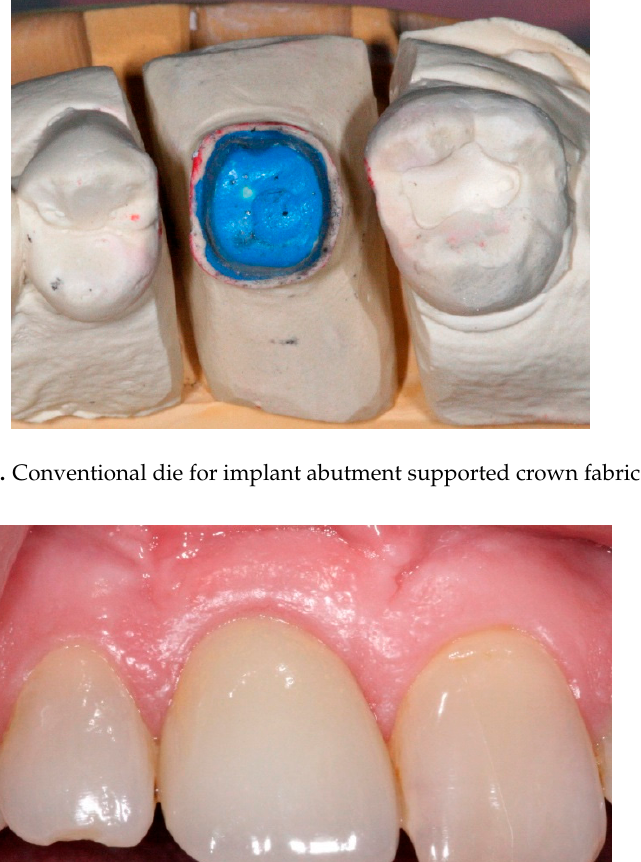
Figure 11. Anterior definitive crown cemented over definitive implant abutment.